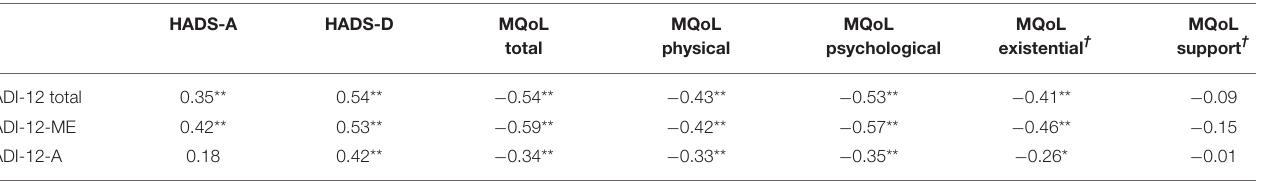
TABLE 3 | Correlation coefficients between ADI-12 and psycho-social